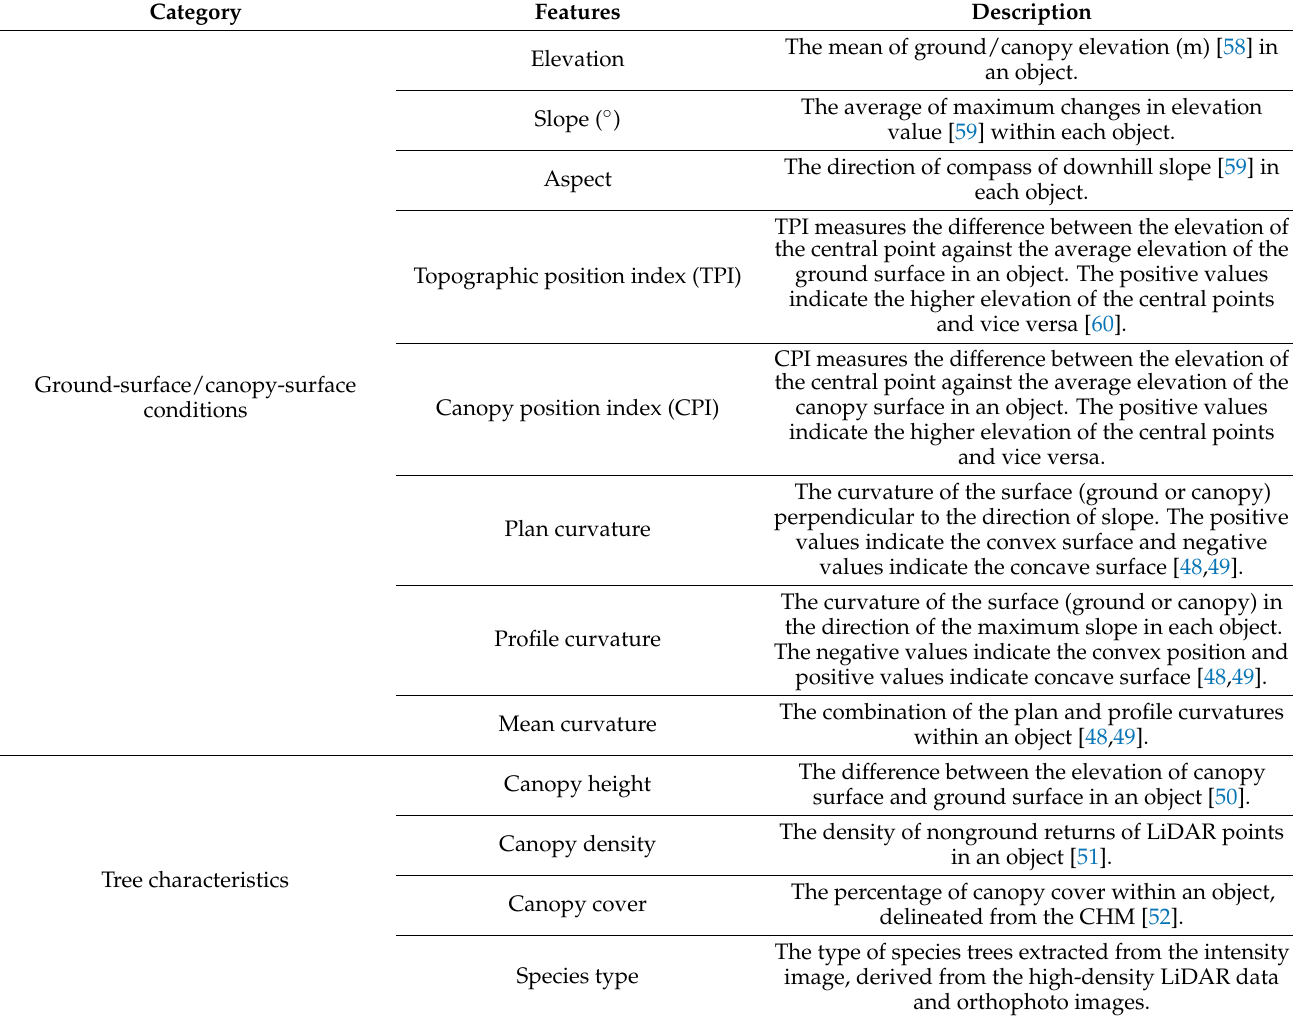
Table 1. Object features affecting on the accuracy of positioning by u-blox ZED-F9P, derived from different metrics of high-density LiDAR